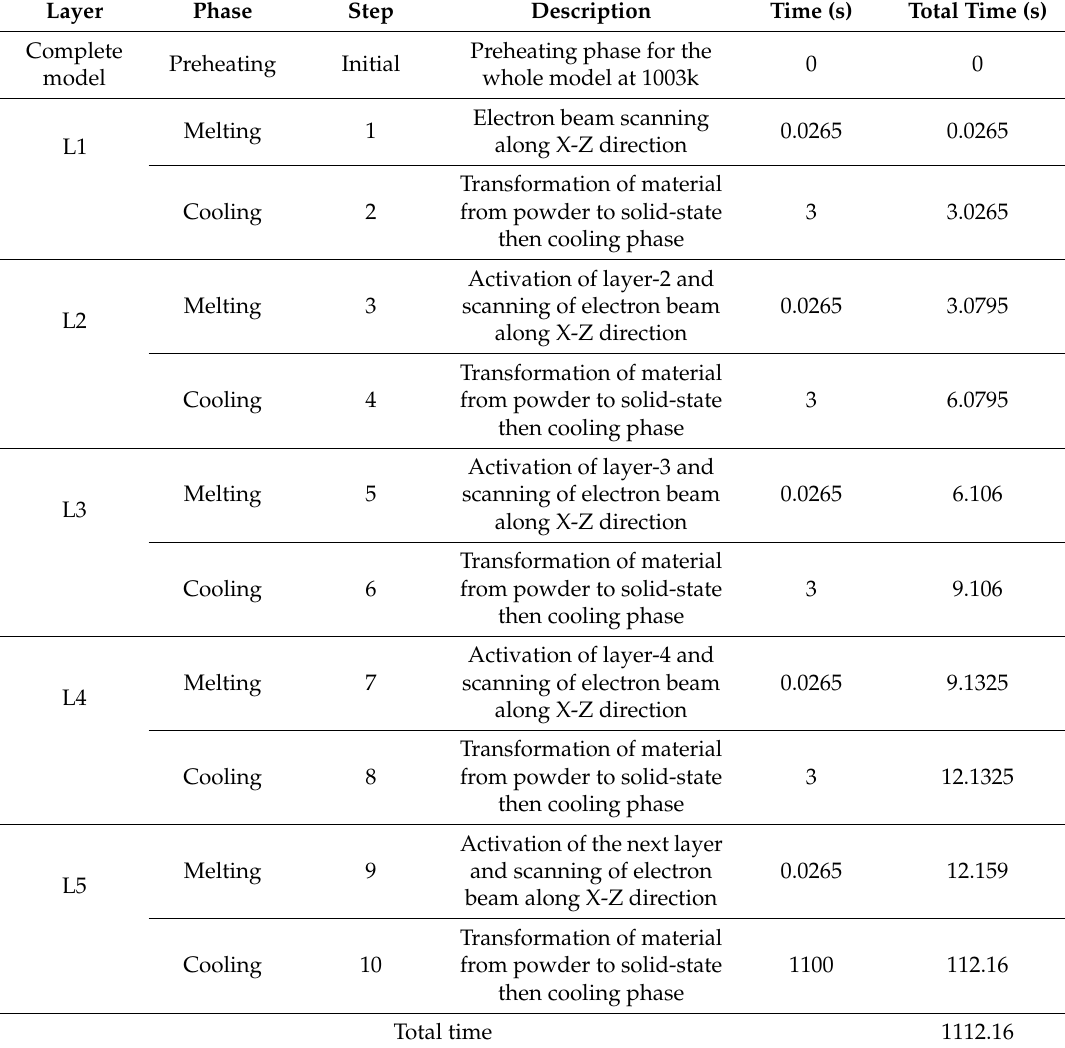
Table 3. Model transformation